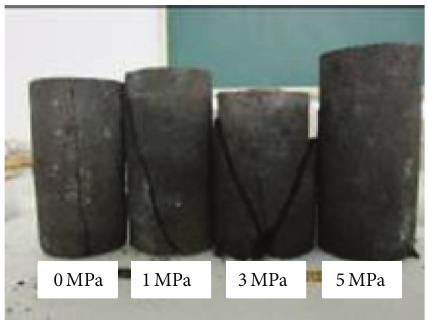
Figure 7: Comparison of failure modes of mudstone samples under different confining pressures.